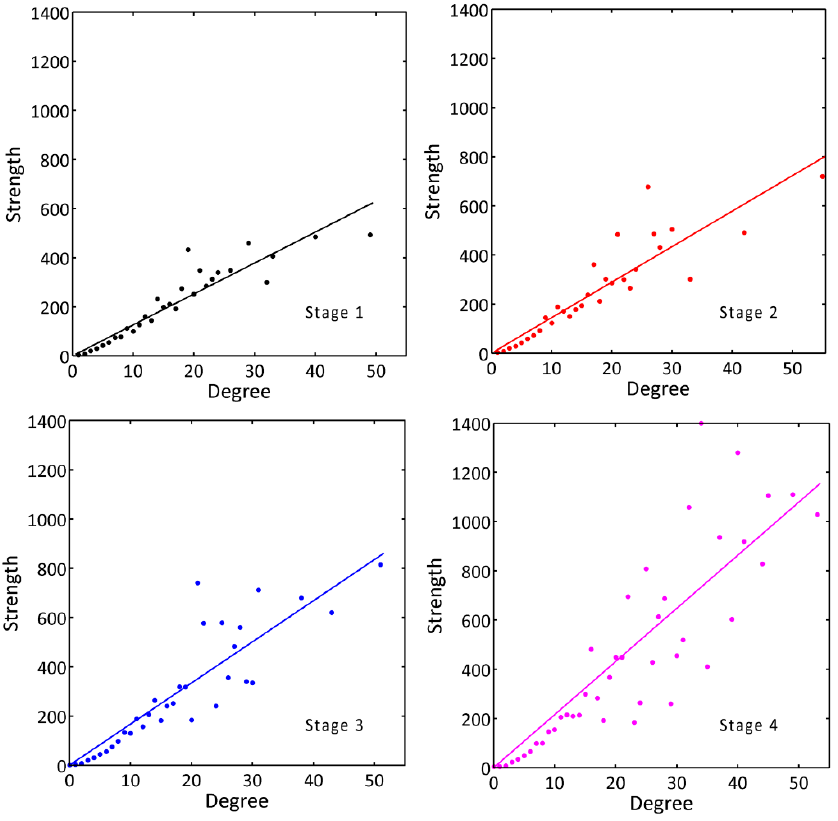
Figure 10. Degree-strength correlation. Table 10. Correlation results of